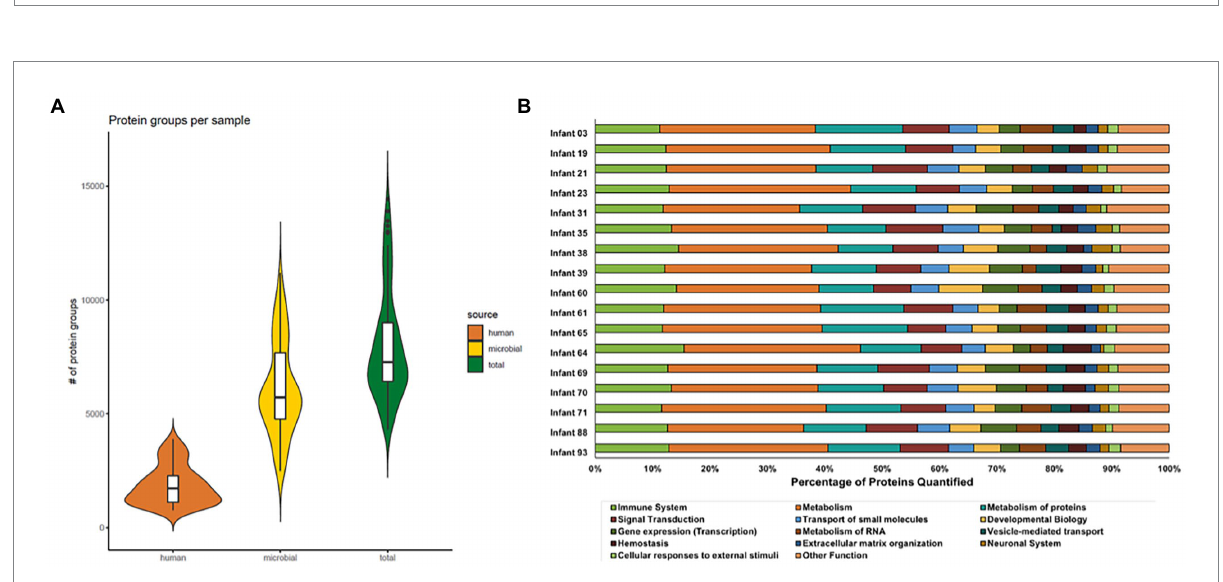
FIGURE 2 Distribution of protein groups identified in each sample for each protein source (A) and the percentage of human proteins quantified in each Reactome annotation category (B) . In panel A, protein group identifications were based on uniquely mapping peptides. Microbial and human proteins were clustered at 100 and 85% sequence similarity, respectively. Each violin plot illustrates the kernel probability density for all samples collected (the width represents the proportion of the data) and the horizontal bars on the box plot depict the median and interquartile range of the distribution. In panel B, the Reactome database was used to annotate human proteins based on proteins that uniquely map to one category. The bar plots show the proportion of proteins in each Reactome category quantified per infant. Among the quantified human proteins, proteins related to immune functions (lime green bars) represent around 10–15% of human protein identifications.